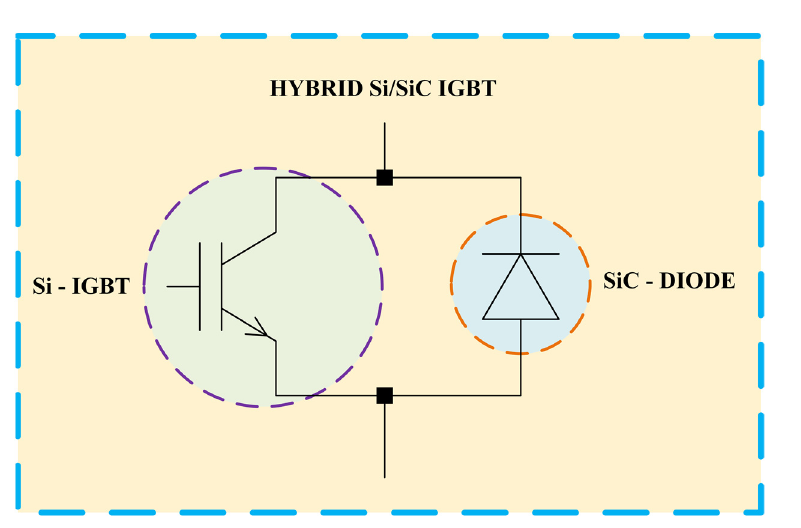
Figure 5. Hybrid Figure 5. Hybrid IGBT.